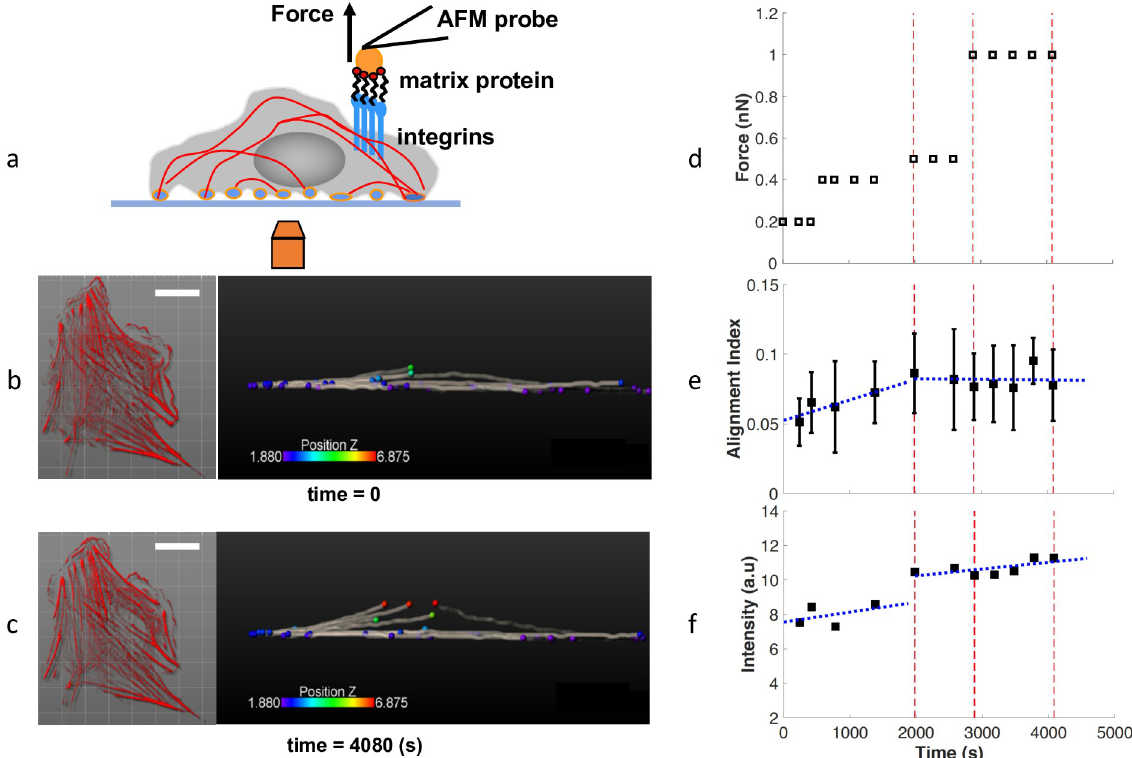
Fig 1. Response of VSMC to external pulling force. (a) Schematic of a VSMC mechanically stimulated with a FN functionalized AFM probe and simultaneously imaged by spinning-disk confocal microscopy. (b-c) Fluorescence images of VSMC expressing mRFP1-actin-7 (left) and the 3D reconstructed image of the representative segmentation of actin filament bundles (right) for before (b) the AFM probe displacement at time 0 min, and after (c) the AFM probe displacement at time 68 min. Scale bar: 20 μ m. Left panels used with permission from JOVE [21]. (d) The scheduled pulling force in three phases: small, intermediate and large forces. (e) The alignment index for the actin filament bundles increased rapidly as small force was applied, but slowed down as the force increased. (f) The normalized intensity for mRFP1-actin-7 increased steadily through all force ranges. Blue lines: piece-wise linear fit for forces below 0.5 nN and � 0.5 nN.